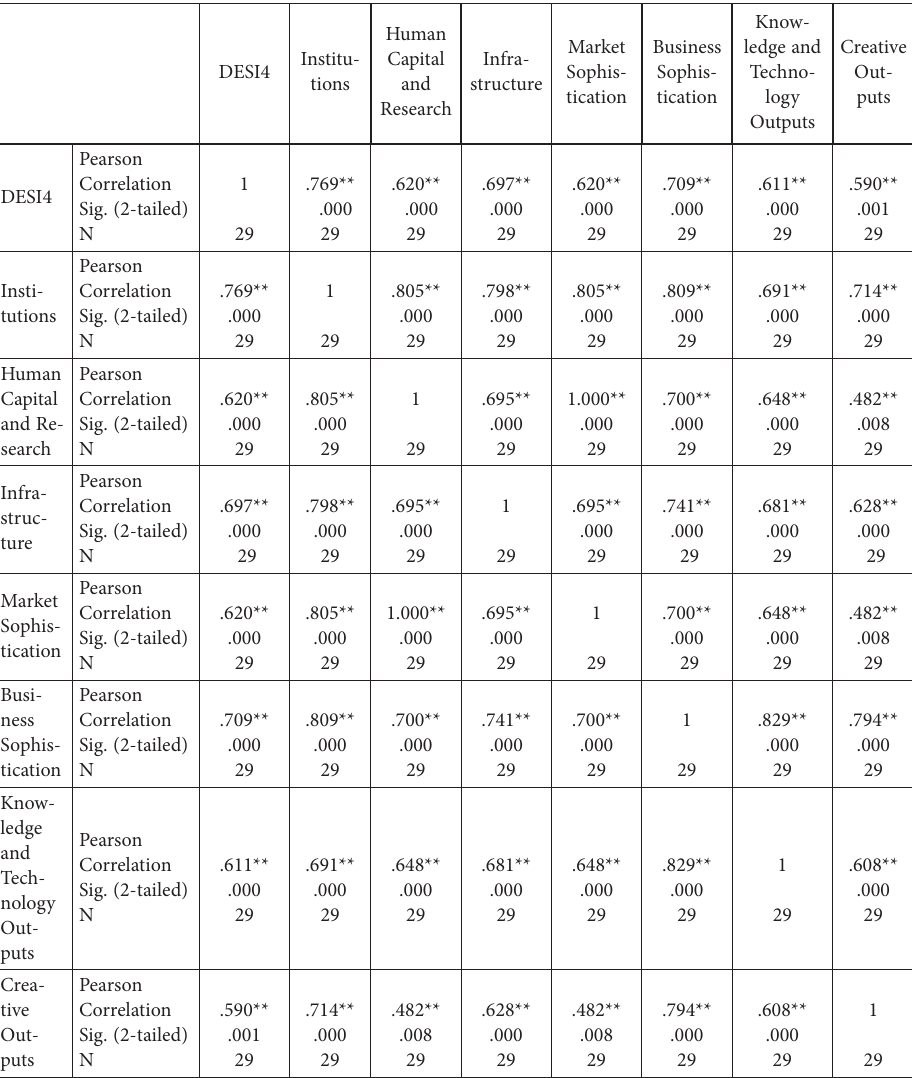
Table A1. Correlations between DESI4 and each pillar of GII and between GII pillars